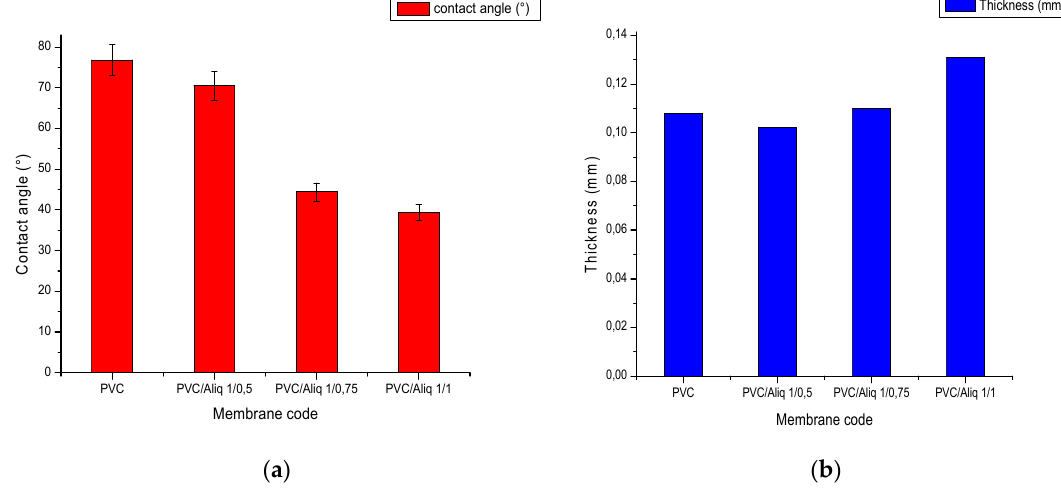
Figure 4. ( a ) PVC/Aliquat-336 membrane contact angle; ( b ) PVC/Aliquat-336 membrane thickness.